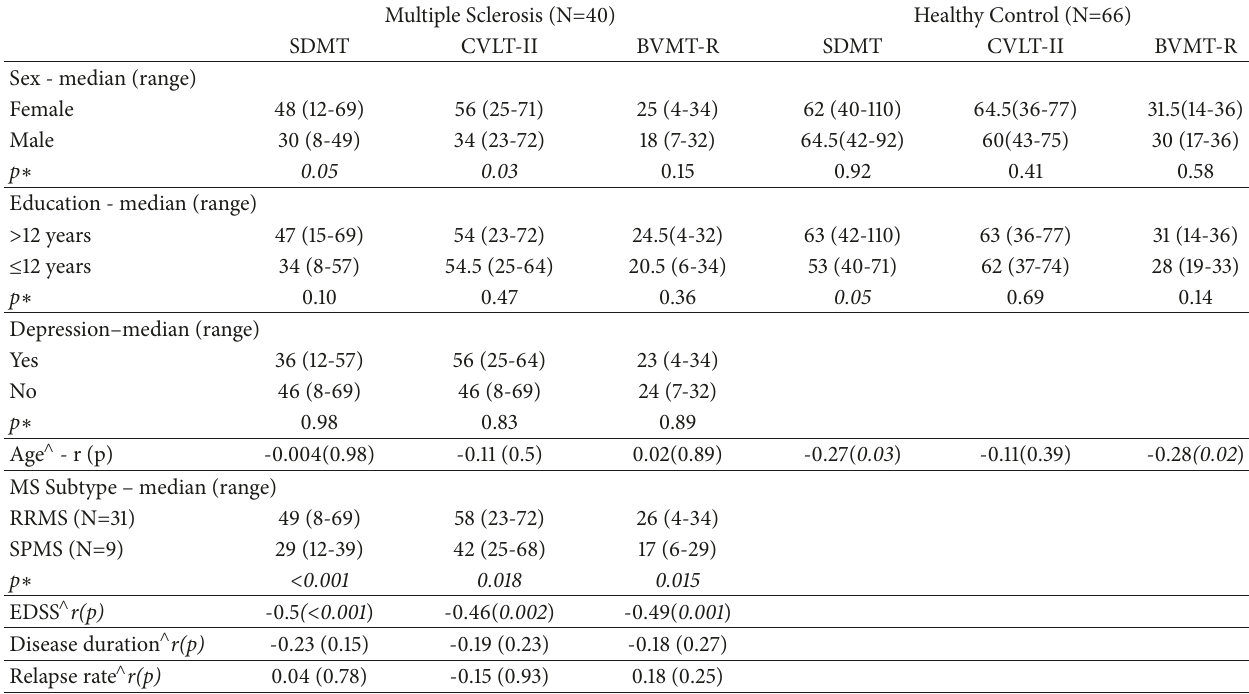
Table 3: Association of BICAMS scores with sex, education, depression, age, MS subtype, EDSS, disease duration, and relapse